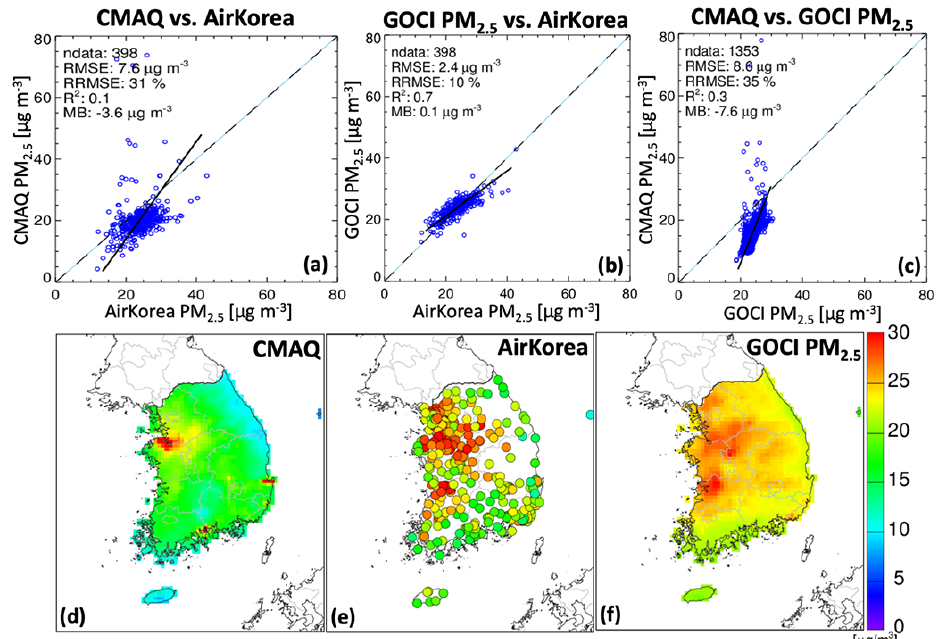
Figure 11. Mean PM 2 . 5 concentrations in South Korea in 2015–2019 as simulated by CMAQ, measured at the AirKorea sites, and inferred from GOCI. Panels (a) , (b) , and (c) show scatterplots comparing the CMAQ and GOCI PM 2 . 5 fields to the AirKorea measurements (398 sites) and CMAQ to GOCI PM 2 . 5 on the 9 × 9km 2 CMAQ grid (1353 grid cells to compare). Panels (d) , (e) , and (f) show maps of the mean 2015–2019 concentrations.